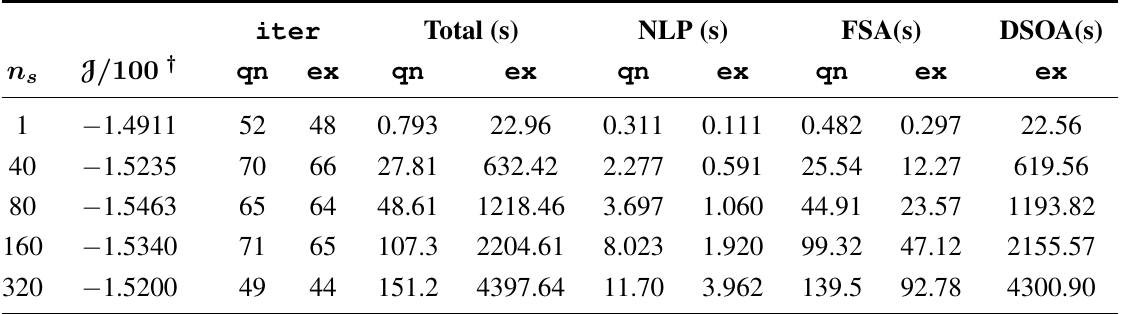
Table 2. Case Study 1: serial computation results comparing Hessian generation